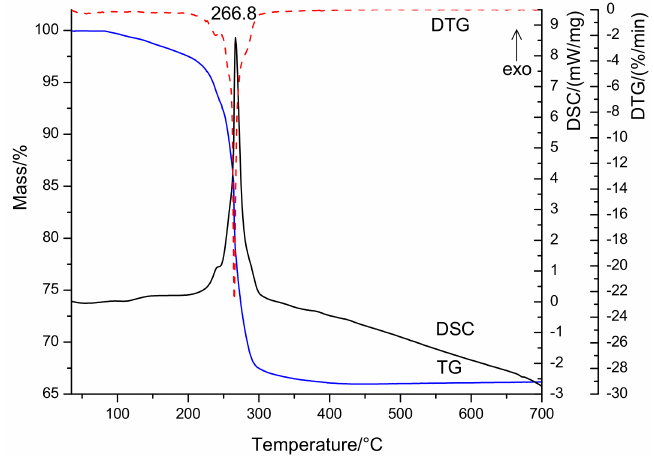
Figure 2. Thermal curves DSC, TG, and DTG of Bi 2 Cu(C 2 O 4 ) 4 · 0.25H 2 O